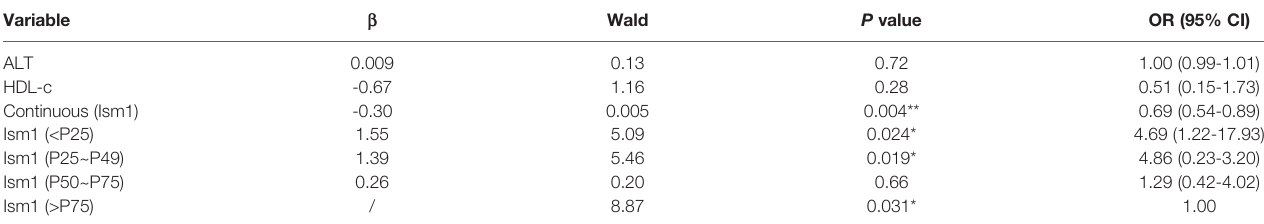
TABLE 3 | OR (95% CI) of T2D associated with ALT, HDL-c and the quartiles of Ism1. Variable b